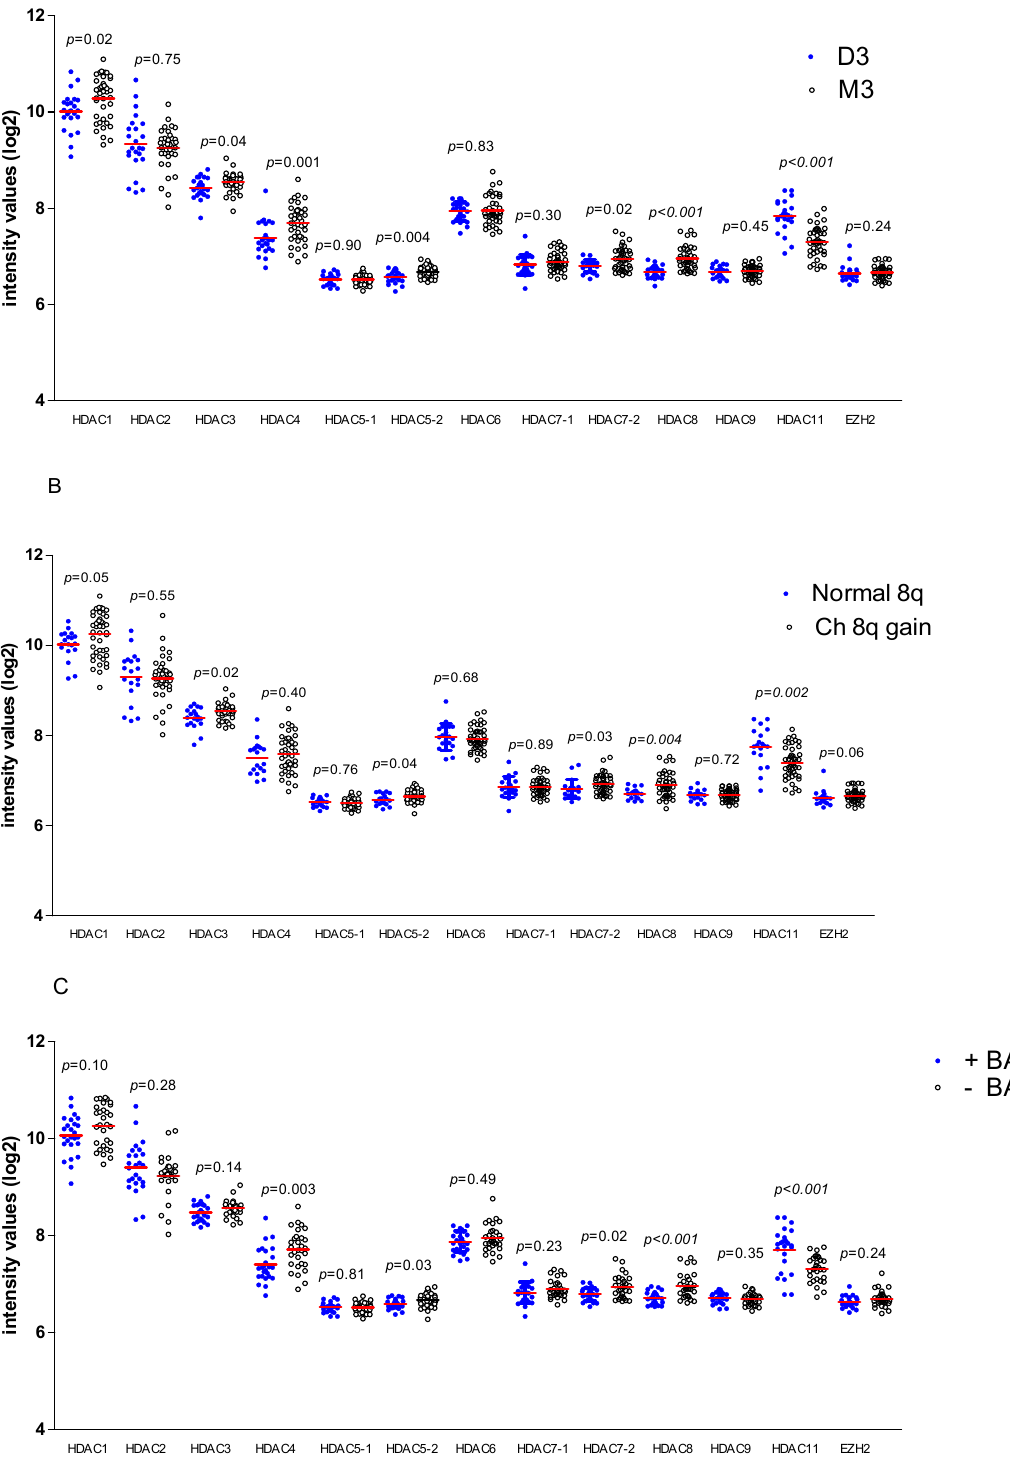
Figure 1. The expression of histone deacetylases (HDACs) in uveal melanoma in relation to the tumour’s chromosome 3, chromosome 8q and BAP1 status. The expression of several HDACs and EZH2 was compared between tumours with ( A ) disomy for chromosome 3 (D3, n = 24) and a monosomy of chromosome 3 (M3, n = 40); ( B ) normal 8q ( n = 19) vs. 8q gain ( n = 45); ( C ) positive staining for BAP1 (+BAP1, n = 25) vs. negative staining for BAP1 (-BAP1, n = 30). A Mann–Whitney U test was applied. Horizontal bars indicate mean gene expression.